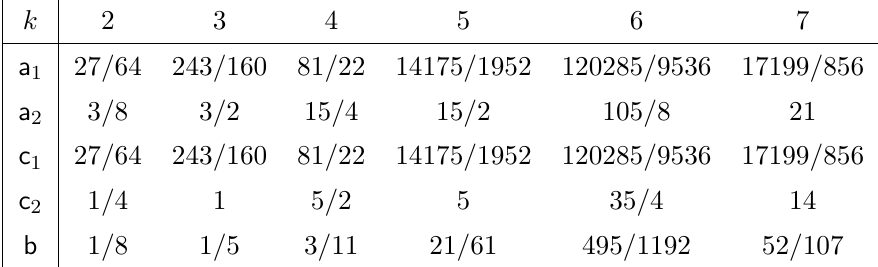
Table 2. Central charge coefficients (with genus one) for various k